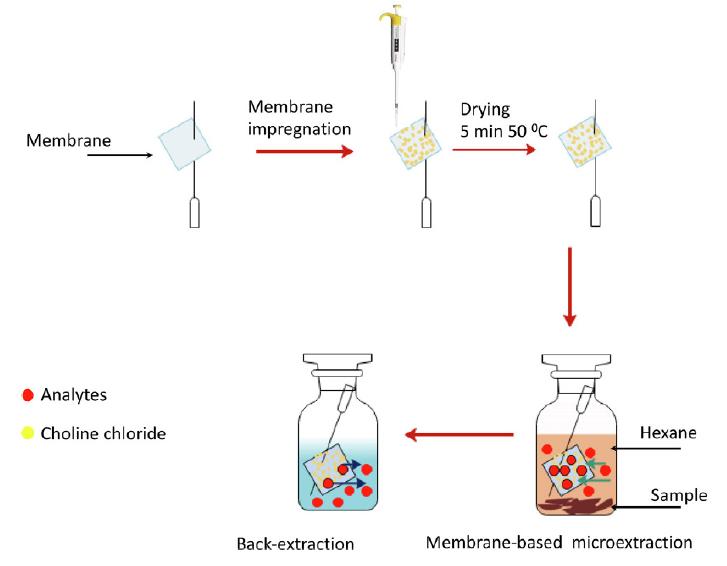
Figure 1. Deep eutectic mixture membrane-based microextraction process diagram. Reprinted from Shishov et al. [60] with permission of Elsevier.